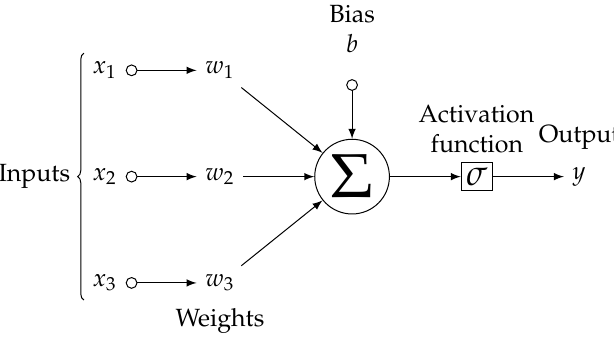
Figure 1. Neural network connections.